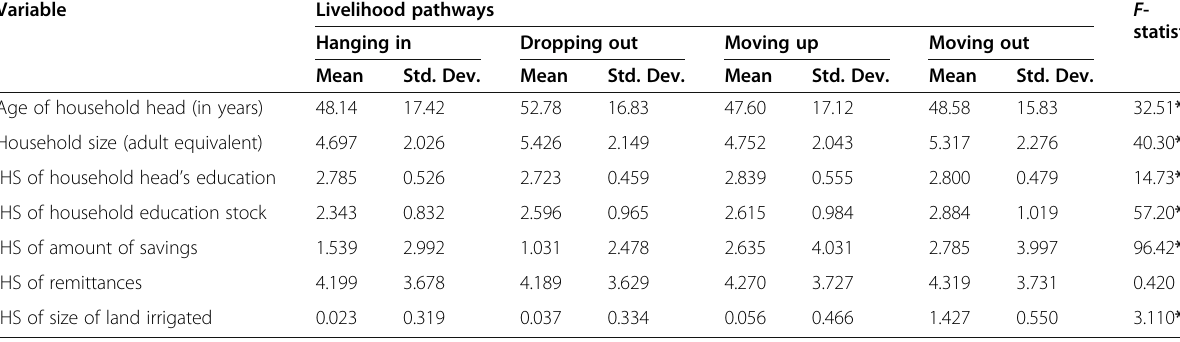
Table 3 Descriptive summary statistics of continuous variables by livelihood pathways